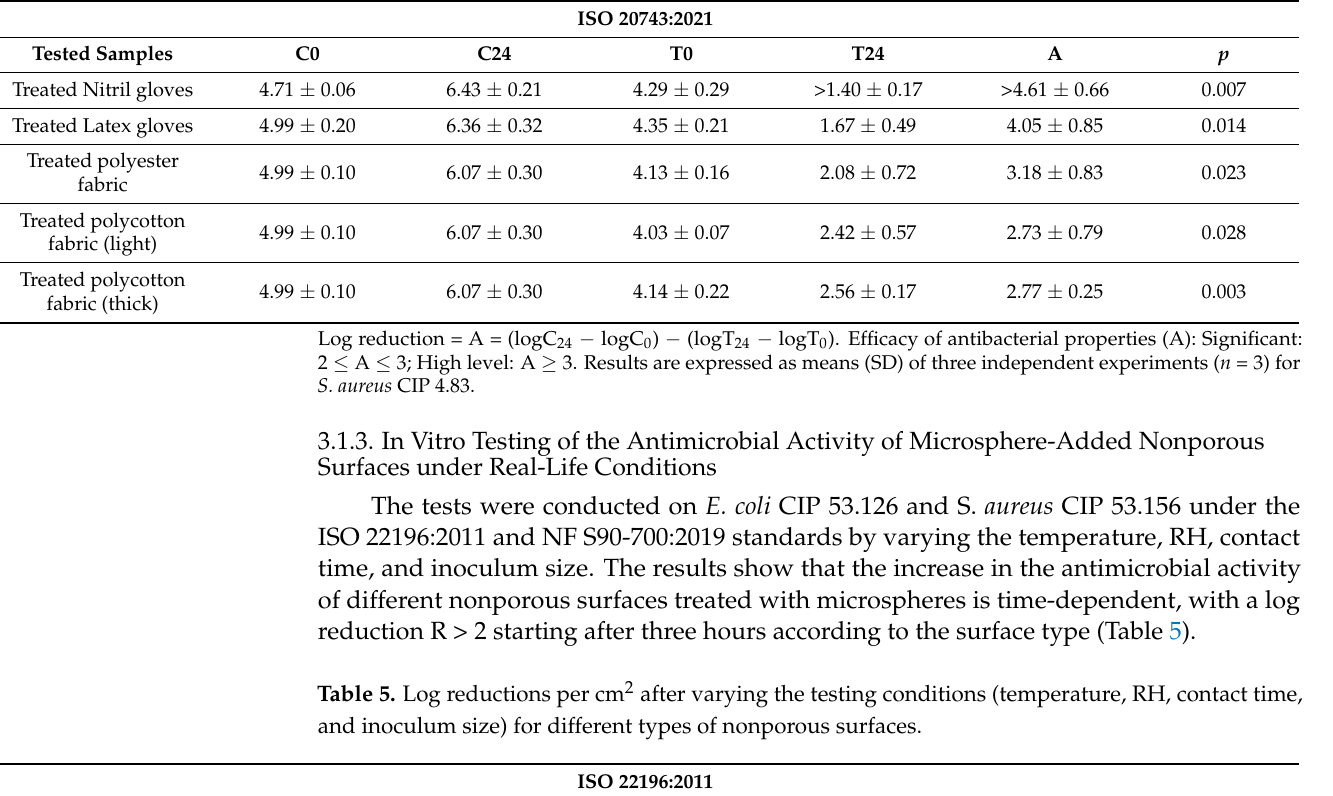
Table 4. Log CFU after 0 h (control C0) and 24 h (control C24 and assay A24) of contact with different types of porous surfaces and log reductions per cm 2 for tests with S. aureus CIP 4.83.